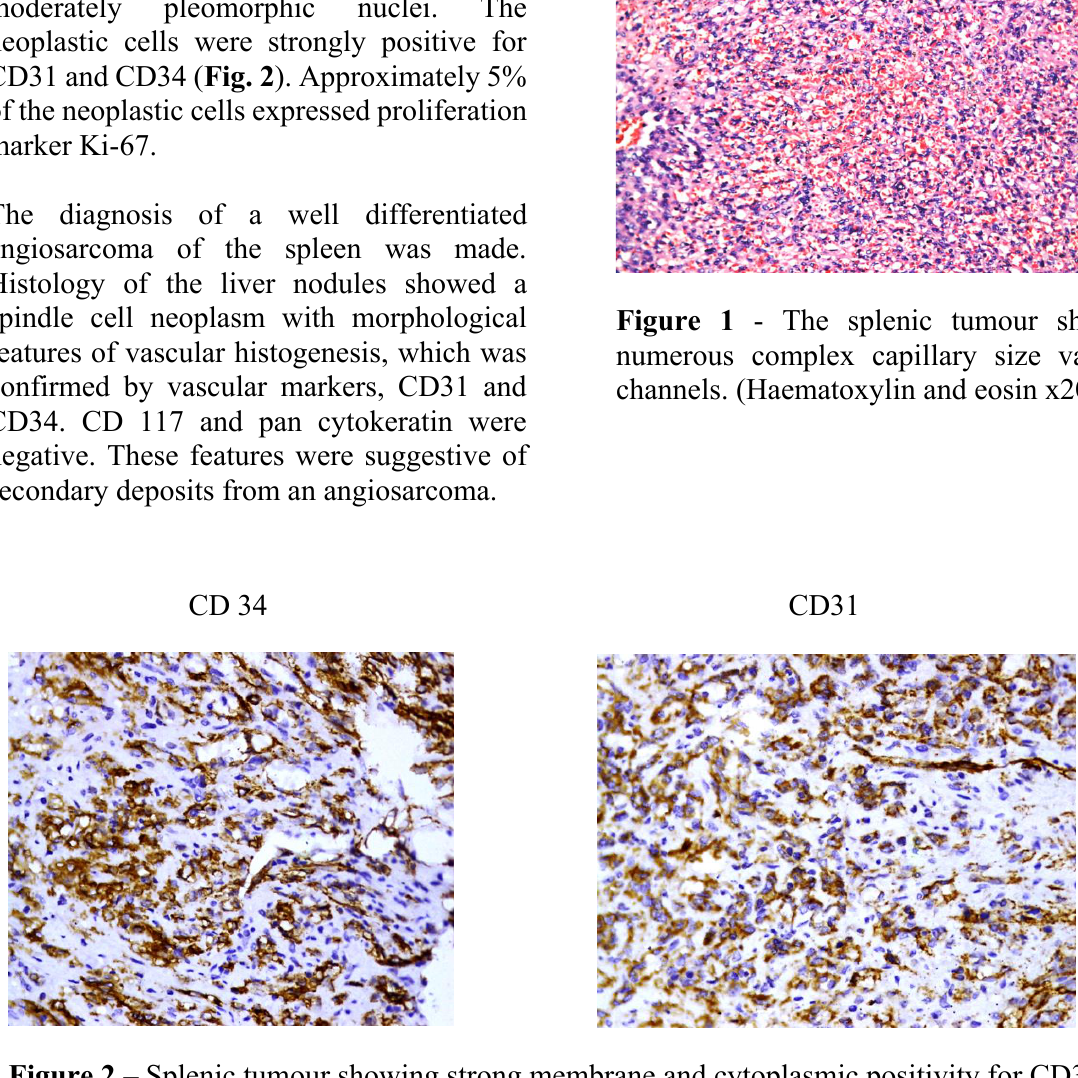
Figure 2 – Splenic tumour showing strong membrane and cytoplasmic positivity for CD34 and CD31. (Dako Monoclonal Mouse Anti-Human, EnVisionTMFLEX system x 400)